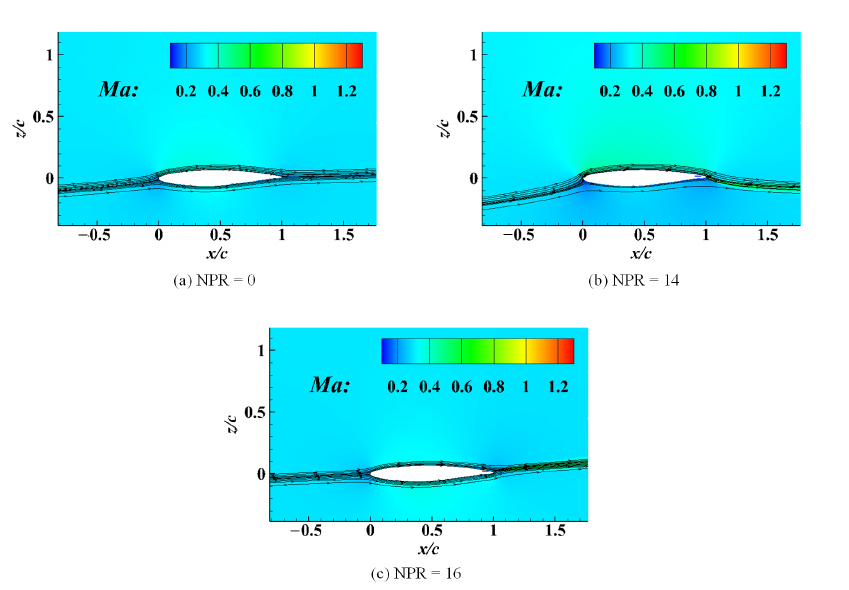
Figure 18. Effects of the CC jet on streamline shapes with increasing NPR for Ma = 0.3, α = 3 ◦ .